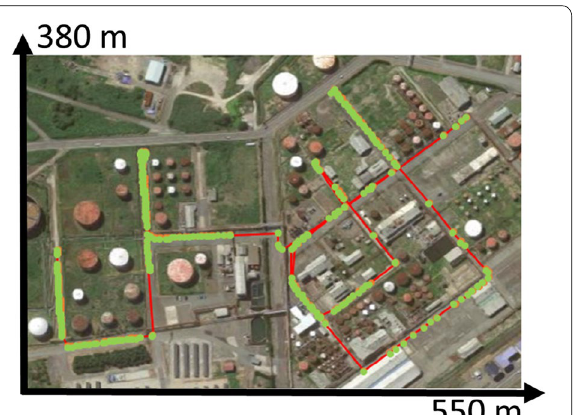
Fig. 4 Petrochemical complex environment. The red path is the robot trajectory; the green path is the RTK-Fix-GPS